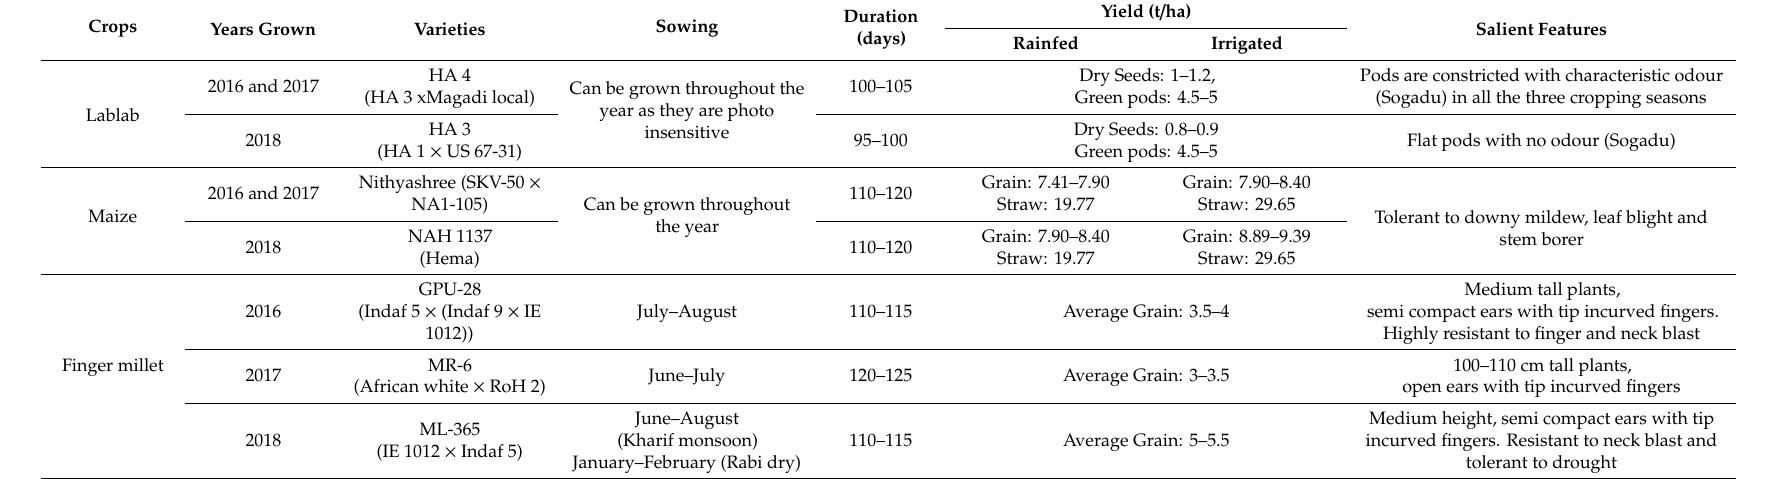
Table A1. Varietal description of the crops lablab, maize and finger millet grown in three years.